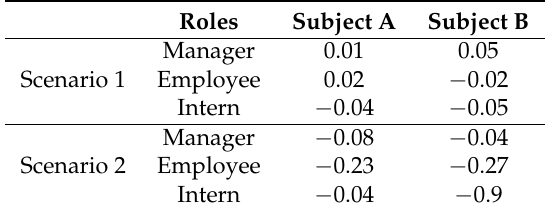
Table 9. Difference among role distance from CV and given margin.